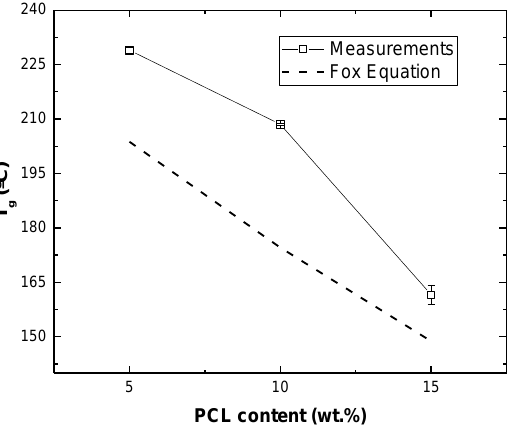
Figure 3. Tg values as a function of PCL content determined experimentally and by using Equation (3).